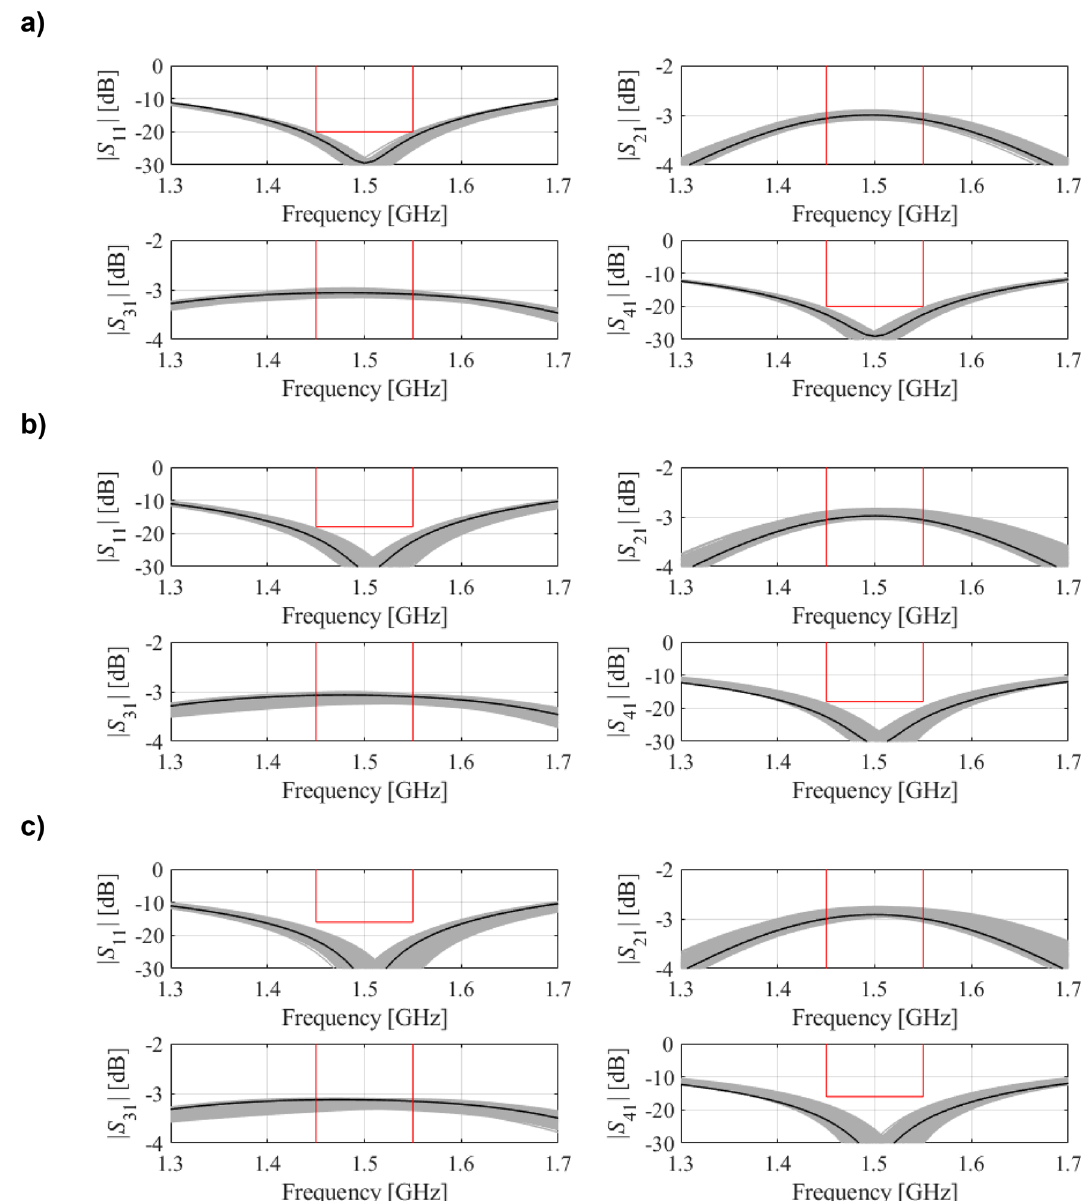
Figure 10. EM-based Monte Carlo analysis of the compact BLC of Fig. 8 at some trade-off points of Table 2. The circuit output at the selected trade-off design is marked black, whereas 500 random trial points rendered following the probability distribution of the variance σ = F r are shown using grey color. The specs are indicated by thin lines: ( a ) design x (2) , ( b ) design x (4) , ( c ) design x (6) the design task (6) and (7) using the TR algorithm with S 1 = S 2 = 0.5 dB, f L .1 = 2.35 GHz and also f R. 1 = 2.45 GHz, f L .2 = 5.15 GHz and f R. 2 = 5.25 GHz. Similarly as for the previous example, six supplementary trade-off points have been rendered, for S simulation-based MC analysis. MC-evaluated yield, for all trade-off solutions, is around one hundred percent. The total cost of generating the entire Pareto set equals 341 EM simulations of the coupler, which corresponds to just 49 EM simulations of the BLC per design, which is consistent with the previous case studies. Similarly as